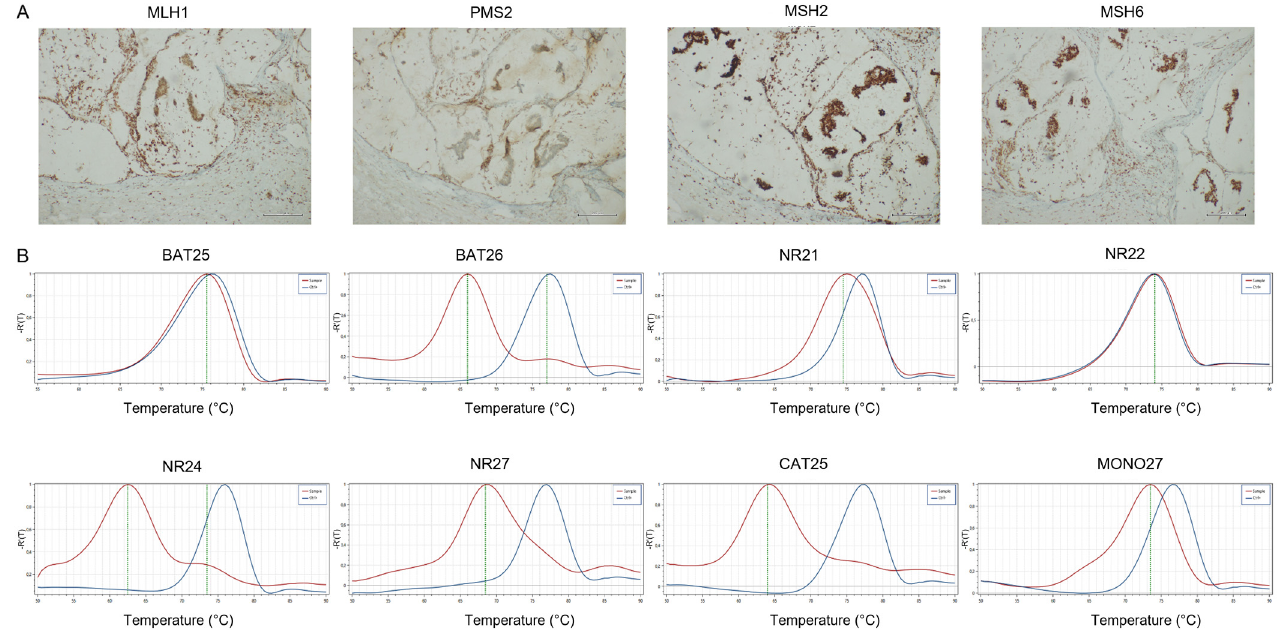
Figure 4. Representative results of CRC case showing paMMR-IHC and MSS by PCR. ( A ) MMR- IHC results: patchy expression of MLH1 and PMS2 in tumor cells with positive internal control (original magnification 10×); intact expression of MSH2 and MSH6 in tumor cells (original magnifi- cation 10×). ( B ) MSS-PCR results: stability of BAT25, BAT26, NR21, NR22, NR24, NR27, CAT25 and MONO27 (red lines indicate samples while blue lines indicate MSS controls).